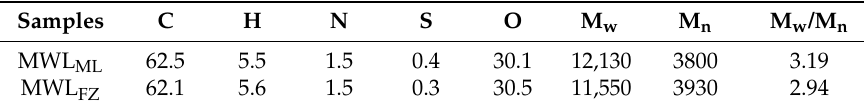
Table 2. Elemental analysis and distribution of molecular weight of MWL ML and MWL FZ .